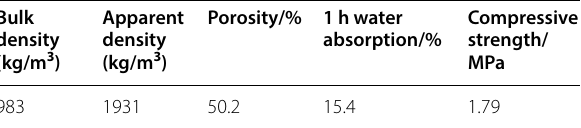
Table 3 Physical performance targets of coral aggregate.